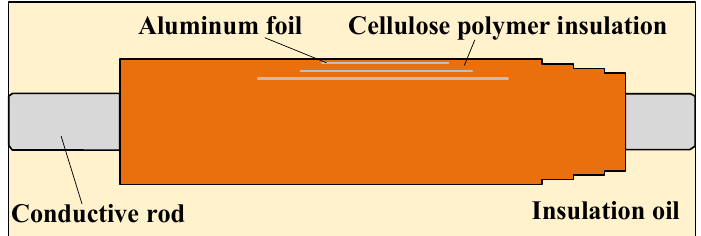
Figure 2. Structure diagram of oil immersed bushing.